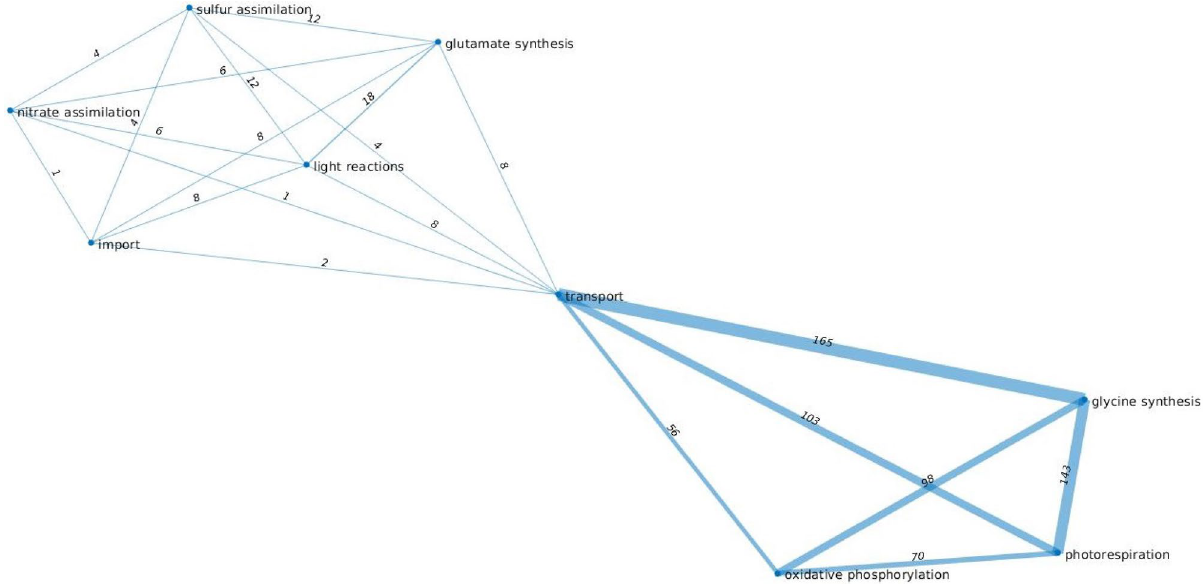
Figure 4. Relation between pathways based on shared trade-offs. A weighted graph shows the number of trade-offs that pathways share with biomass reactions for limiting carbon growth conditions in the model of A. thaliana . Here, nodes represent the pathways and the weighted edge between the two nodes shows the number of shared trade-offs between two pathways, determined by the number of reactions from two pathways that participate in the same